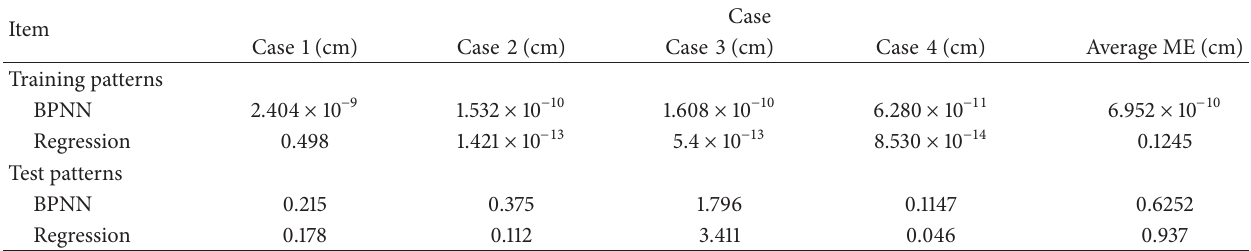
Table 5: Maximum errors (ME) of height by BPNN and regression analysis.